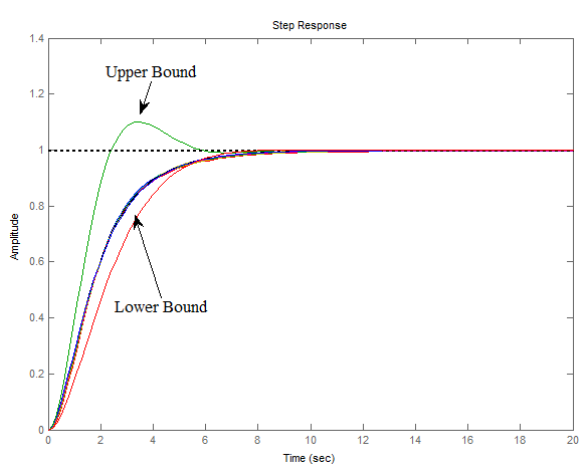
Figure 17. Step response of the system for horizontal